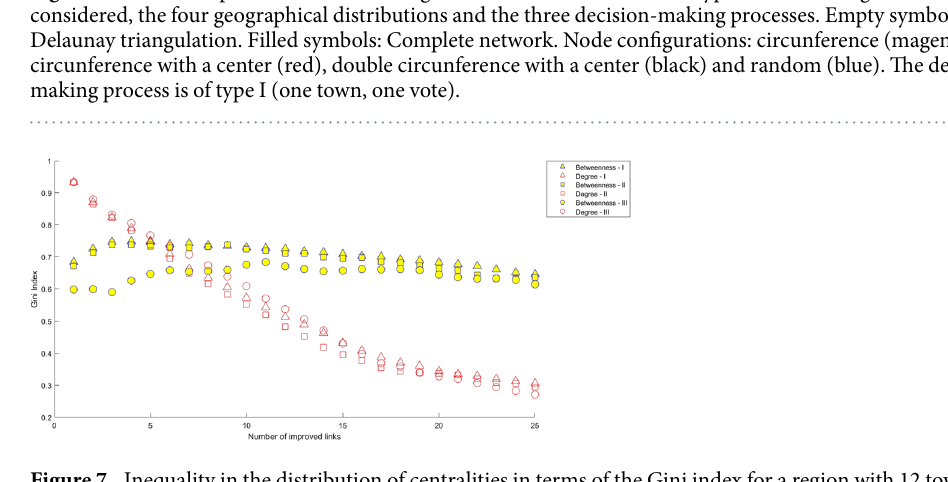
Figure 7. Inequality in the distribution of centralities in terms of the Gini index for a region with 12 towns with a uniform node distribution, the Delaunay triangulation connecting networks considered and the three decision-making processes. The decision-making process is of type I (one town, one vote; triangles), type II (weighted by population, squares) and type III (weighted by traffic, circles). Yellow: betweenness centrality; red, degree